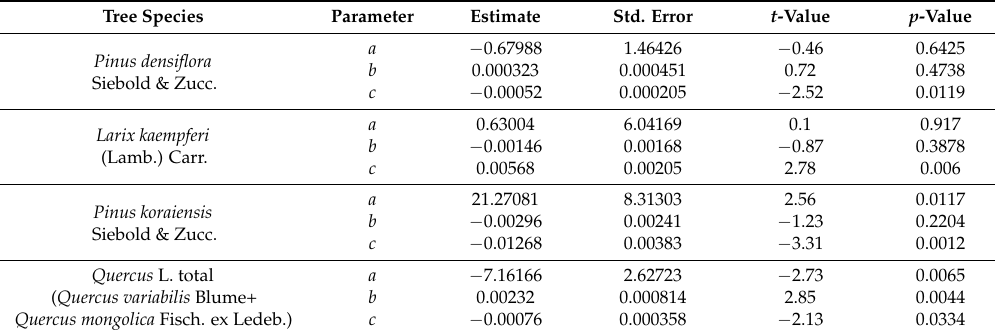
Table 6. Estimated parameters and associated standard errors for Equation (5) by using residuals and temperature for each tree species.